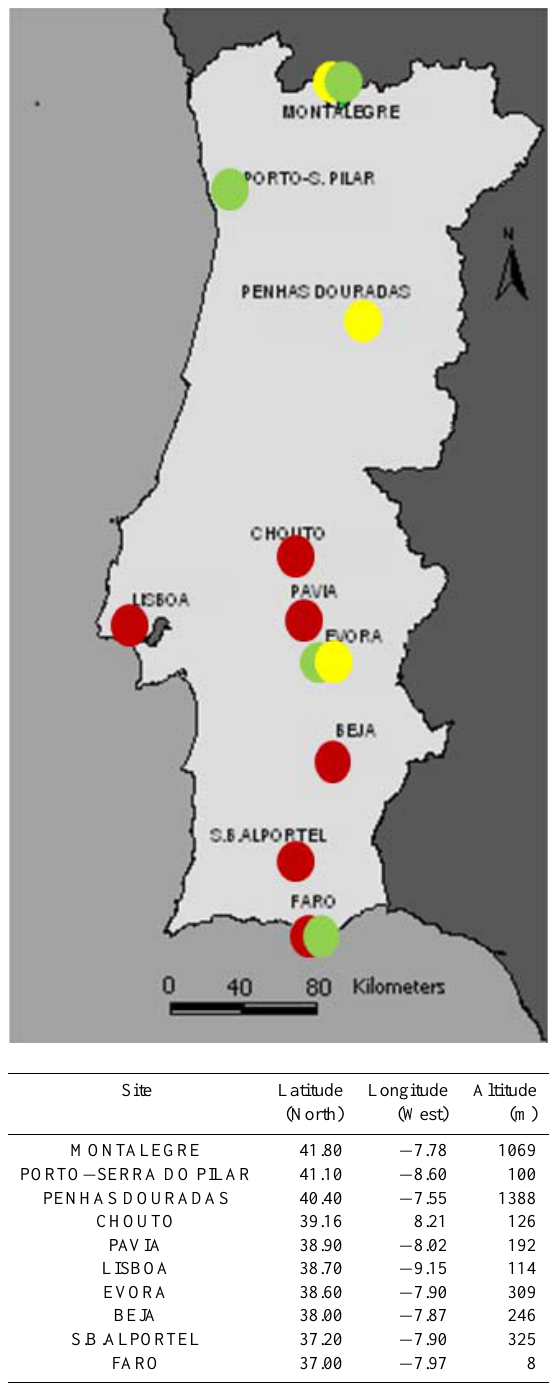
Fig. 1. Portugal (location of the stations). The colors refer to the type of behaviour shown by drought dynamics in each location as described in Fig. 4 and analysed for each location in Figs. 5 and 6. Red circles refer to a cycles behaviour, yellow to a trend for aggra- vation, blue for a decreasing trend and green for no trend nor cyclic behaviour; mixed colors indicate that no clear typical behaviour was